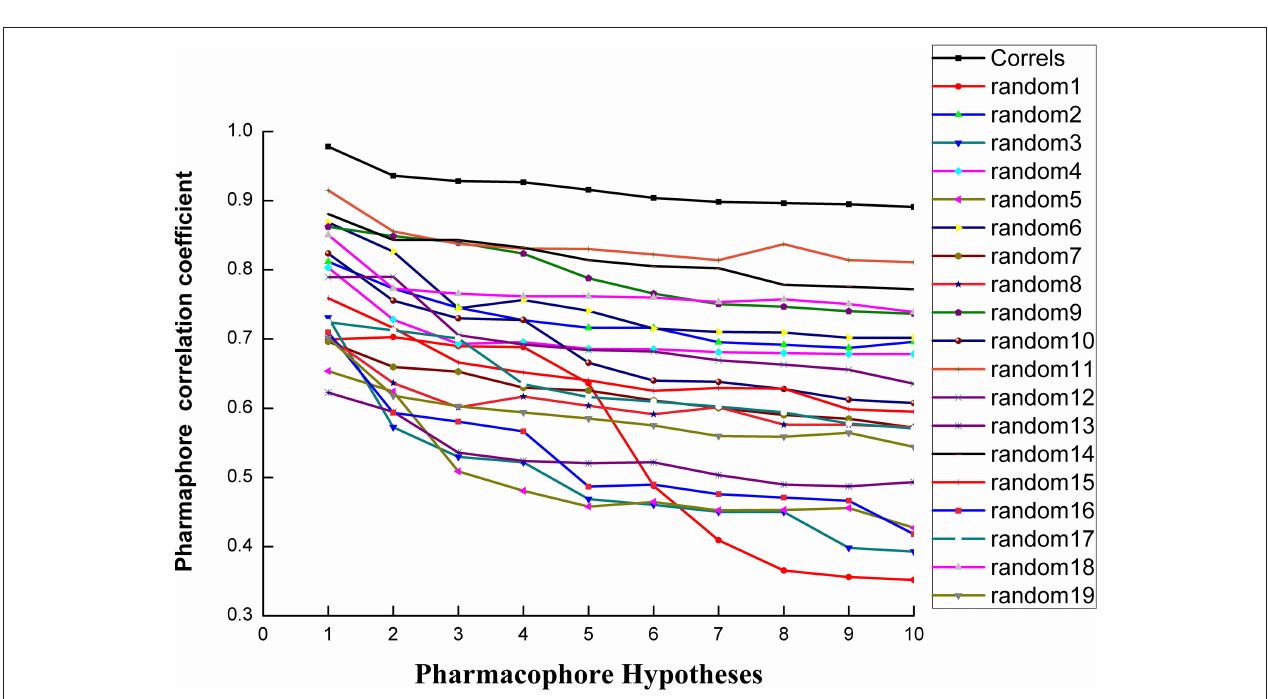
FIGURE 7 | The difference in correlation coefficient between HypoGen runs and the scrambled runs. The 95% confidence level was selected.